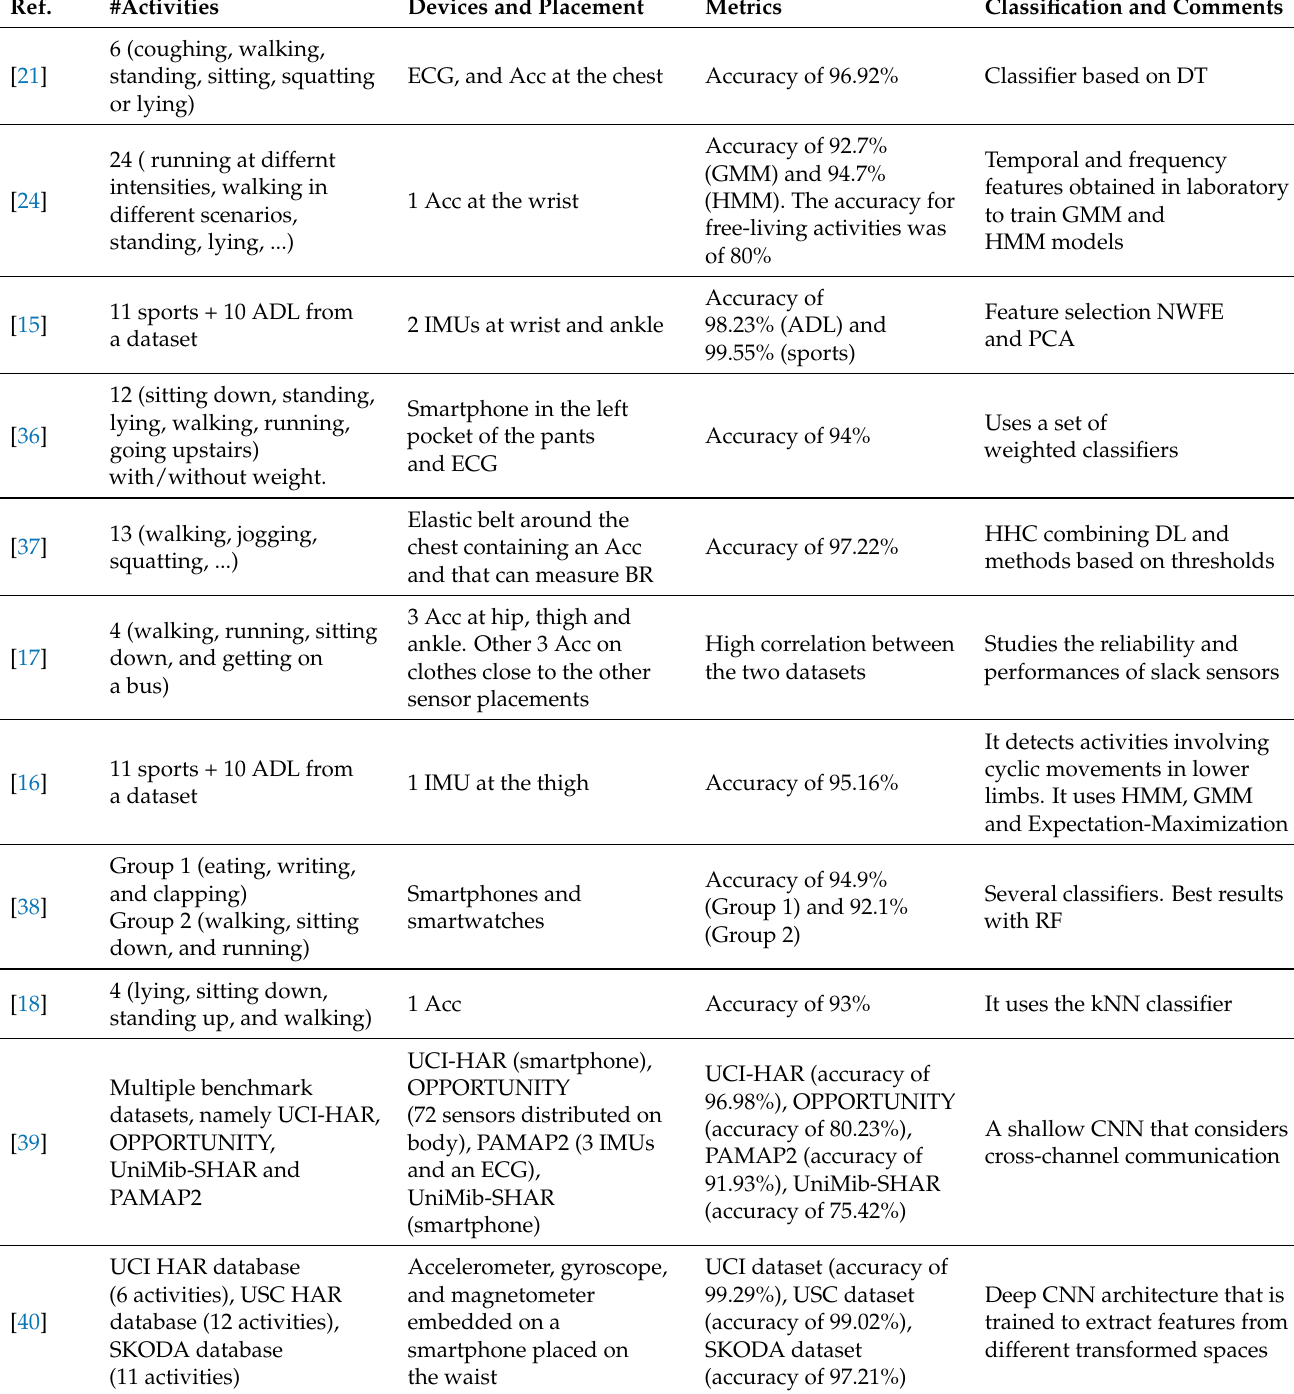
Table 2. Description of selected studies for HMA identification. Some acronyms: accelerometer (Acc), activities of daily living (ADL), breathing rate (BR), convolutional neural networks (CNN), deep learning (DL), decision tree (DT), electrocardiography (ECG), electromyography (EMG), gaussian mixture model (GMM), hierarchical hybrid classification (HHC), hidden Markov models (HMM), inertial measurement unit (IMU), nonparametric weighted feature extraction (NWFE), principal component analysis (PCA), random forest